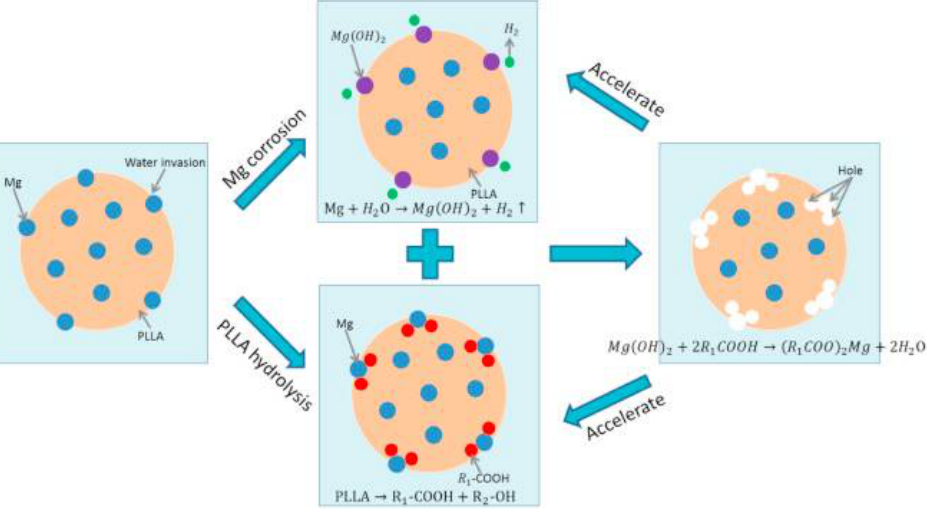
Figure 4. The mechanism of accelerated degradation of polymers by Mg incorporation [61].